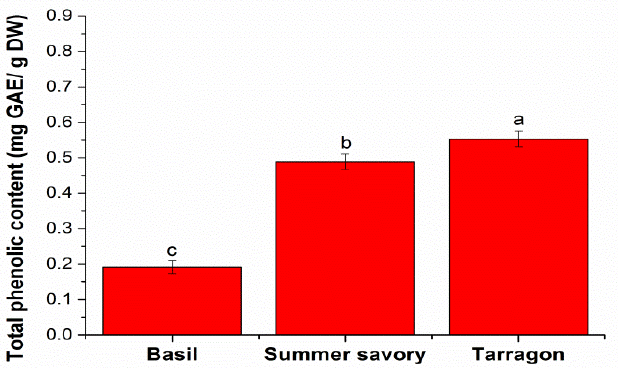
Figure 1. Comparative diagram of total phenolic content in the spices taken in study. Different letters (a, b, c) mean significant differences between the spices, determined by Tukey’s test ( p < 0.05).